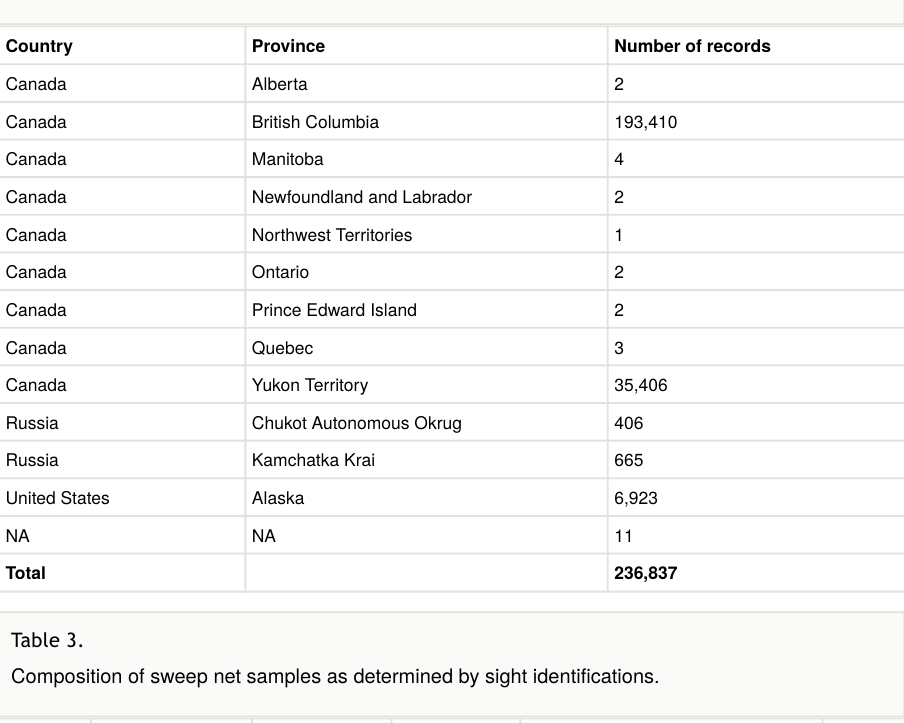
Library composition by country and province/state. Country and province values of NA indicate sequences lacking corresponding geographic data.